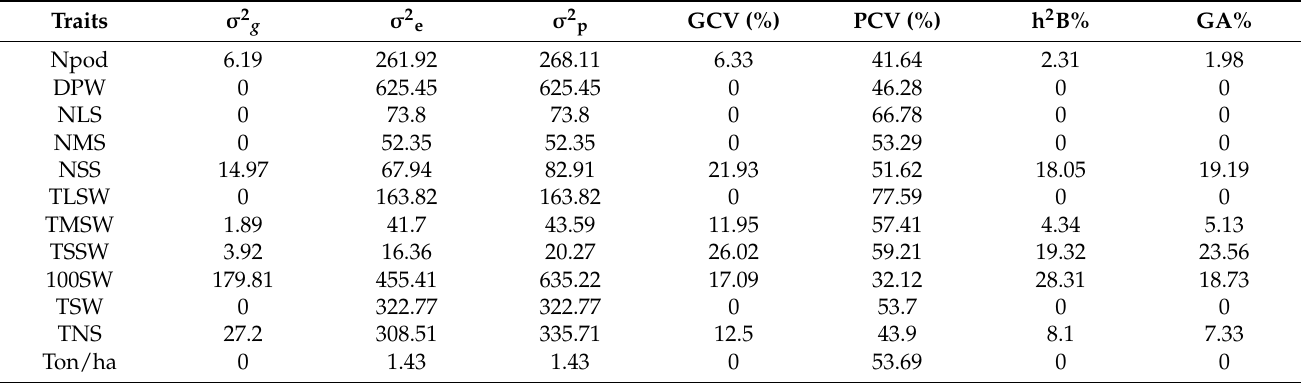
Table 6. Estimates of variability, heritability and genetic advances of the yield traits for 28 lines of Bambara groundnut.